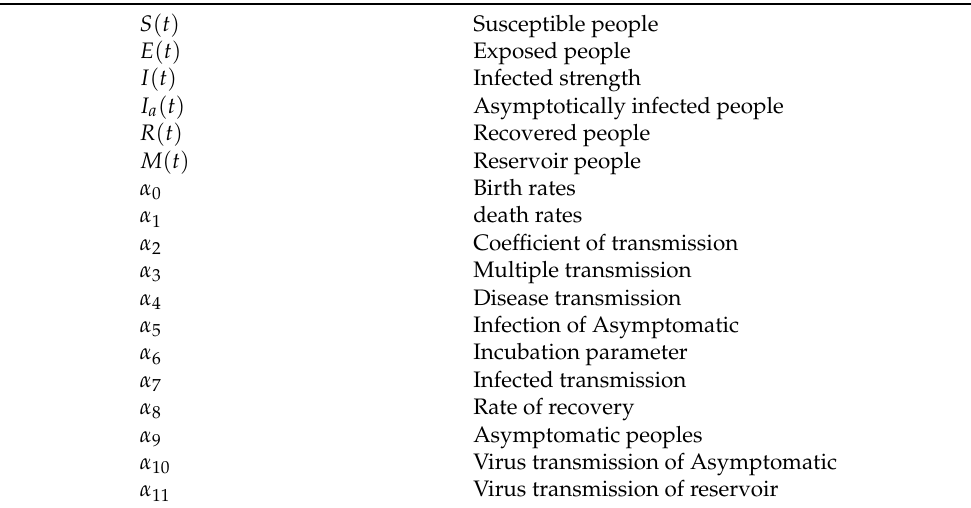
Table 1. The proposed model variables and parameters